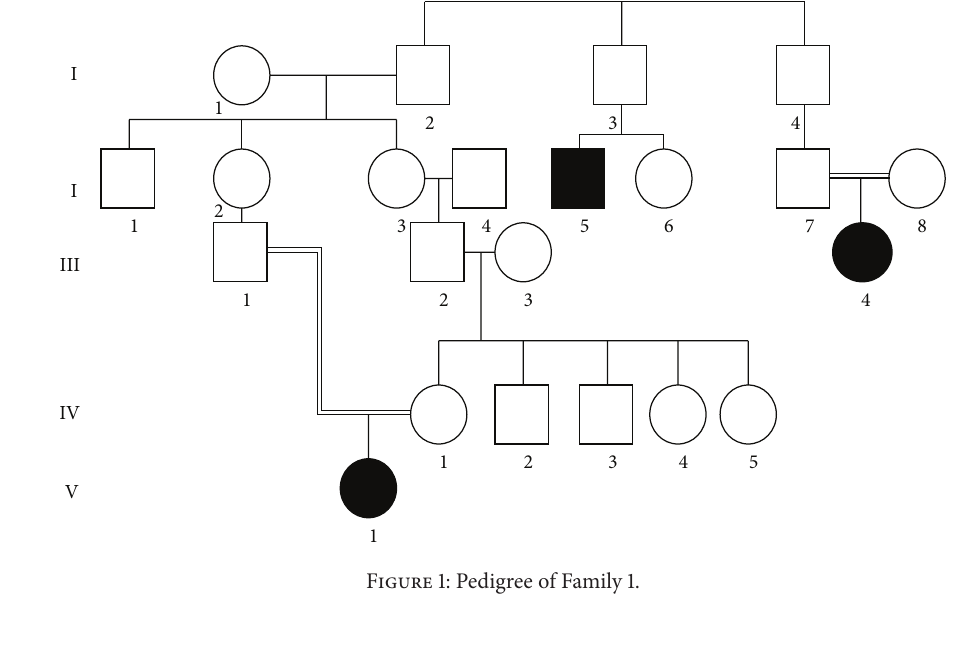
Figure 1: Pedigree of Family 1.